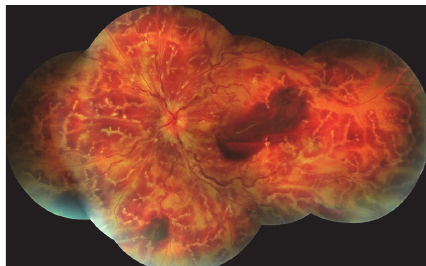
Figure 1: At presentation, left fundus image shows perivascular, white, and continuous sheathing of vascular structures starting from optic disc and extending to periphery. Papillary edema and subhyaloid hemorrhage in macular area were also observed.